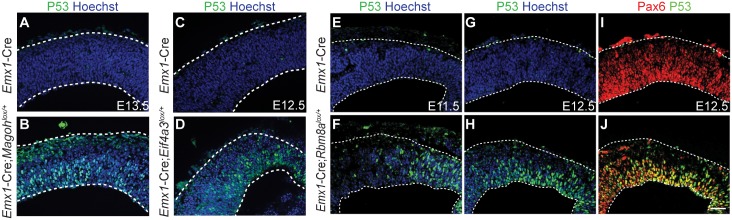
EJC haploinsufficiency induces P53 activation.(A-J) Coronal sections of cortices from E13.5 Emx1-Cre (A), E13.5 Emx1-Cre;Magohlox/+ (B), E12.5 Emx1-Cre (C, G, I), E12.5 Emx1-Cre;Eif4a3lox/+ (D), E11.5 Emx1-Cre (E), E11.5 Emx1-Cre;Rbm8alox/+ (F), and E12.5 Emx1-Cre;Rbm8alox/+ (H,J) embryonic cortices stained for Hoechst (blue), P53 (green), and Pax6 (red), with co-localization indicated in yellow. Sections were demarcated with dotted lines. Each image is representative of at least 3 independent biological samples. Scale bar, A-J, 50 μM.